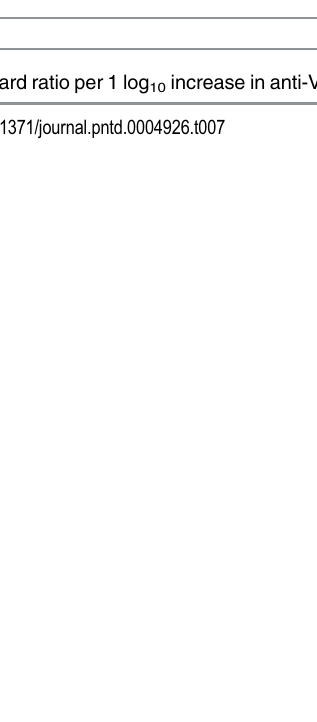
S1 Fig. Challenge doses dispensed to 92 participants according to batch (co-challenged par- ticipants) and typhoid challenge outcome. TD, typhoid diagnosed, filled circles; nTD Typhoid not diagnosed, clear circles. Challenge dose administered was measured by direct plat- ing from the challenge suspension onto tryptone soya agar (Oxoid) prior to colony counting ). Challenge doses ranged from 1.46 – 2.66x10 4 CFU S . after 24 hours incubation (37°C, 5%CO 2